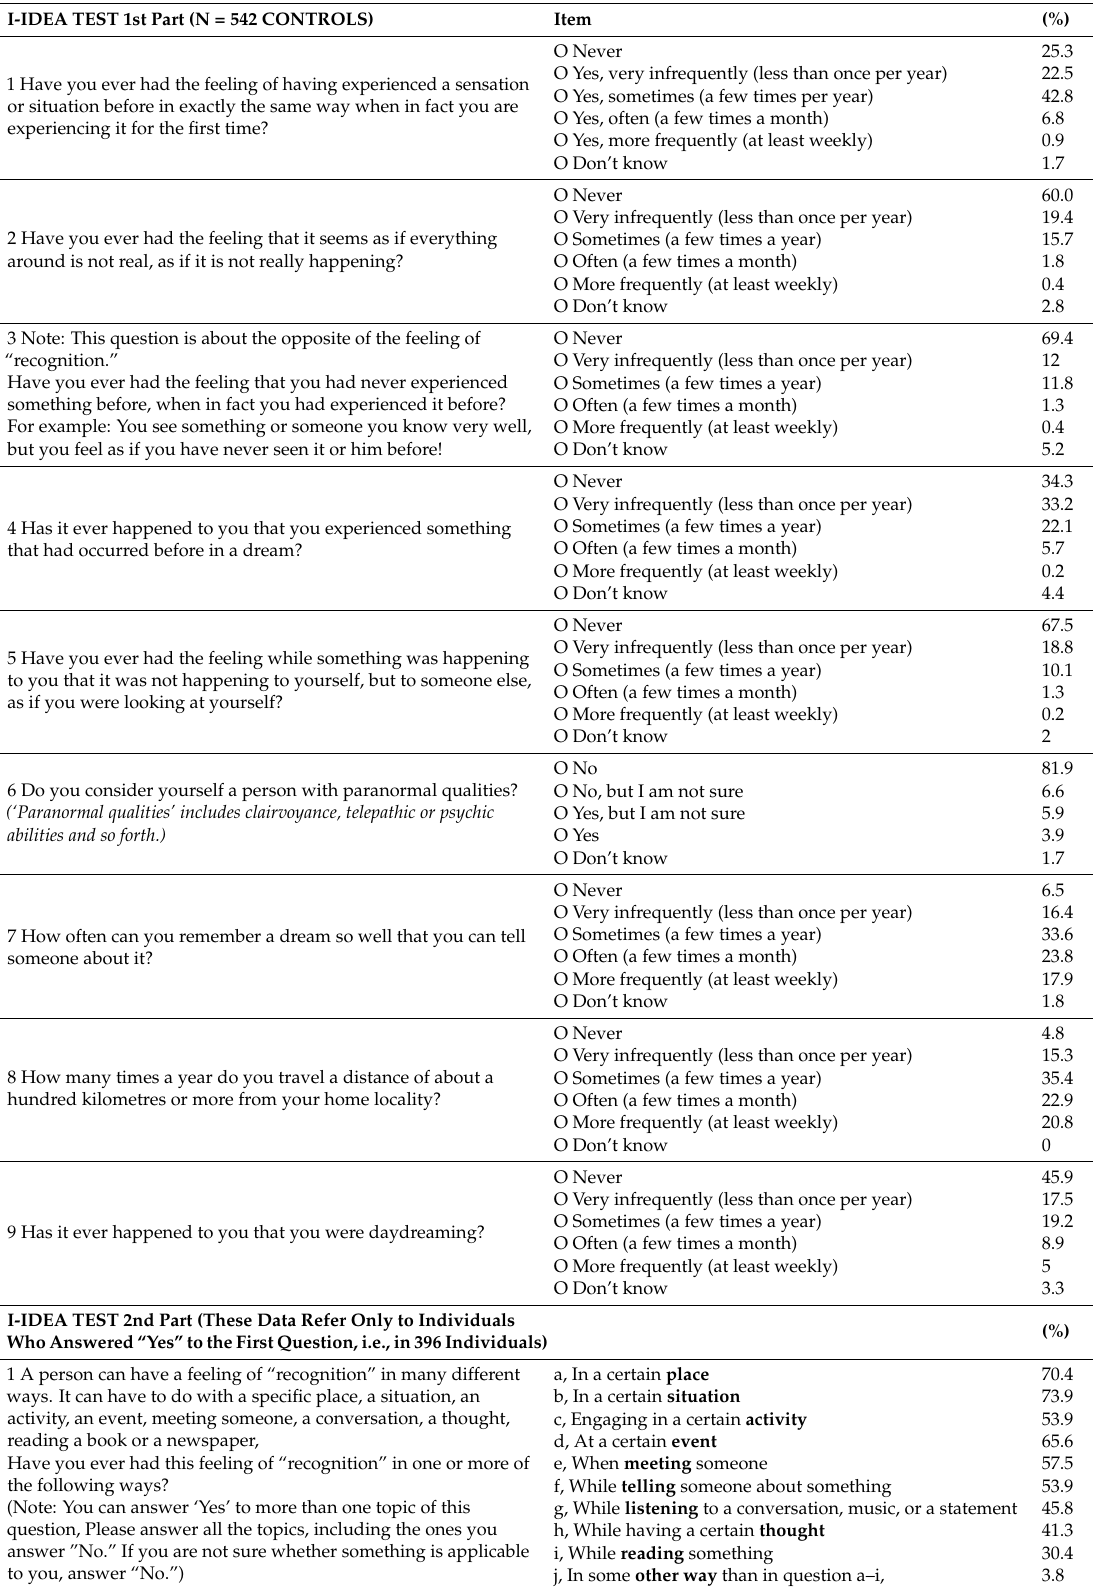
Table 1. Percentage of answers of each Italian Inventory D é j à Vu Experiences Assessment (I-IDEA)